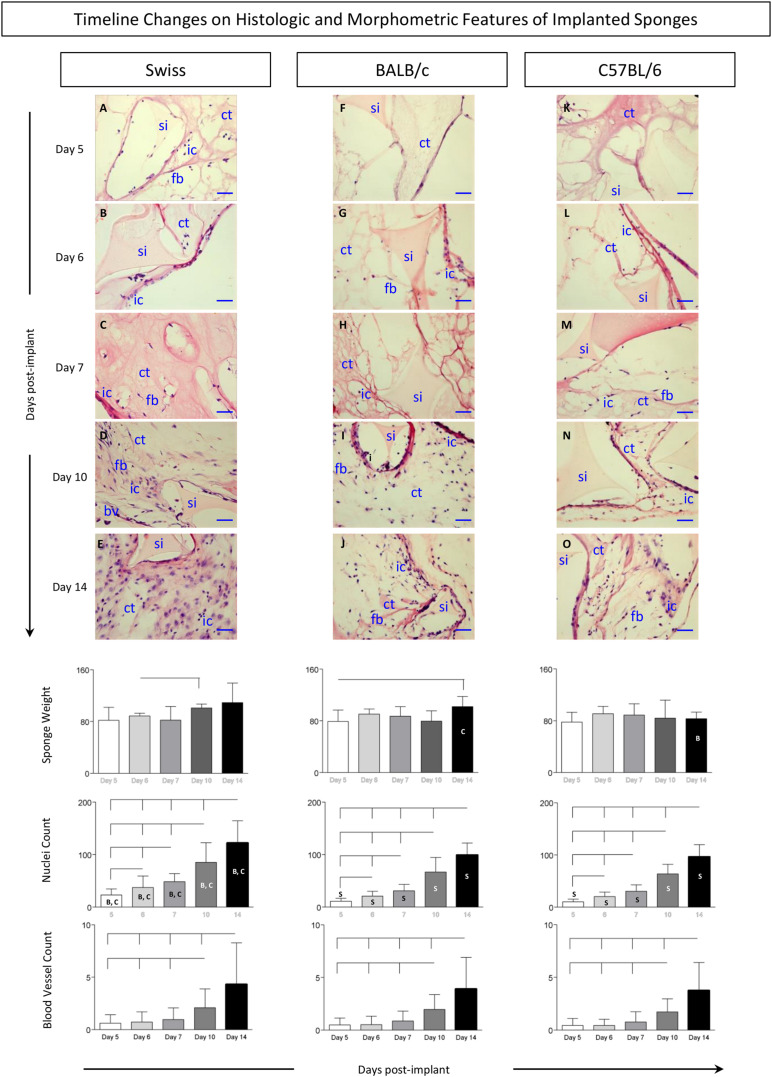
Histologic and morphometric features of implanted sponges. The sponge disks were subcutaneously implanted and removed at Day5, Day6, Day7, Day10, and Day14 post-implant. (Top panels) Sections of sponge implants were stained by the Hematoxylin/Eosin (HE) method, as described in Materials and Methods. Early and late events representing the most relevant changes in sponge implants removed from Swiss (A–E), BALB/c (F–J), and C57BL/6 mice (K–O) illustrate the progressive filling of sponge implants (si) with connective tissue (ct), inflammatory cells (ic), fibroblasts (fb), and blood vessels (bv) upon image acquisition under light microscopy (40X objective,— = 100 μm). (Bottom panels) Sponge weight, quantification of inflammatory infiltrate (cell nuclei), and blood vessel counts were monitored throughout the experimental procedures. Data are presented as mean ± standard deviation. Significant differences at p < 0.05 are underscored by connecting lines within the lineage and by letters “S,” “B,” and “C” for comparisons with Swiss, BALB/c, or C57BL/6 mice, respectively.